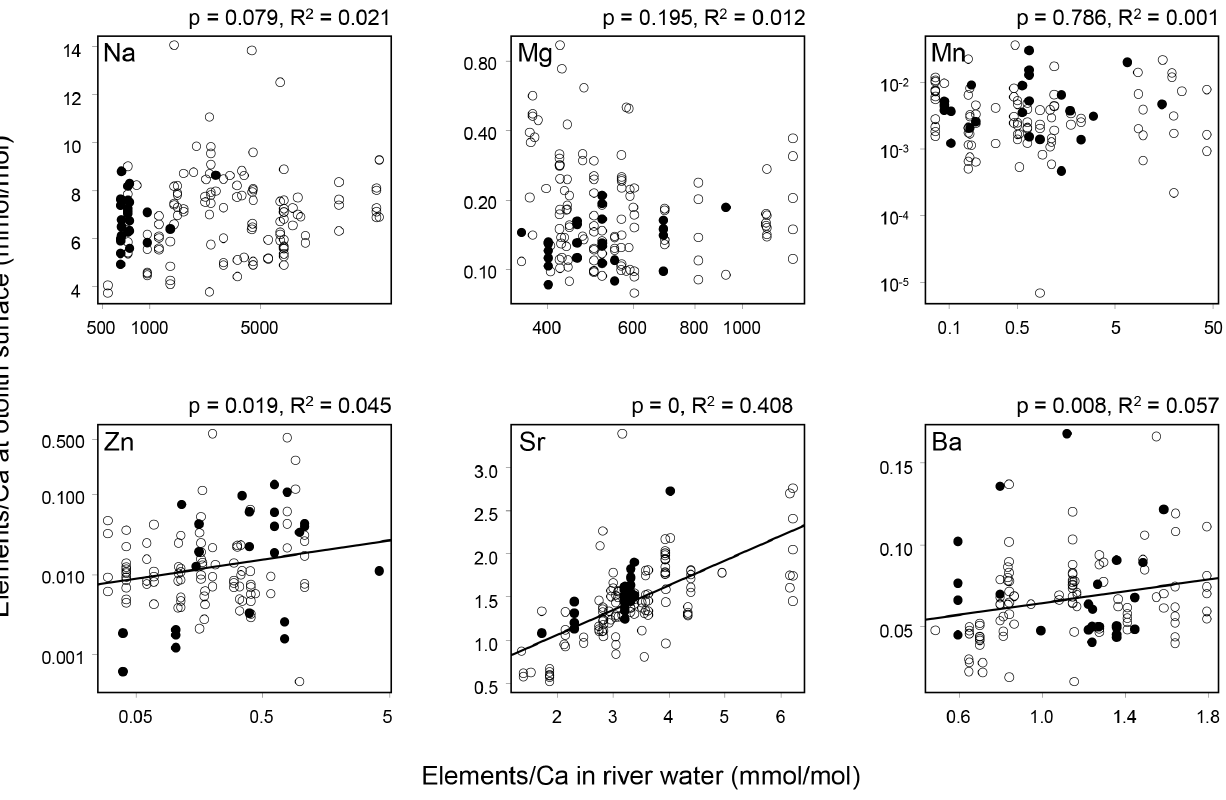
Figure 4. Otolith surface elemental signatures plotted against river water signatures. Open circle: H. siamensis . Closed circle: H. lobatus . Linear regression lines based on combined data from both species are superimposed, for which statistical significance and the coefficient of determination are shown above each panel.